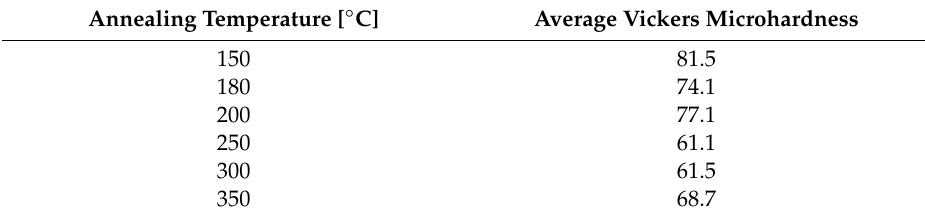
Table 6. Average hardness values of DRECE processed and annealed 5754